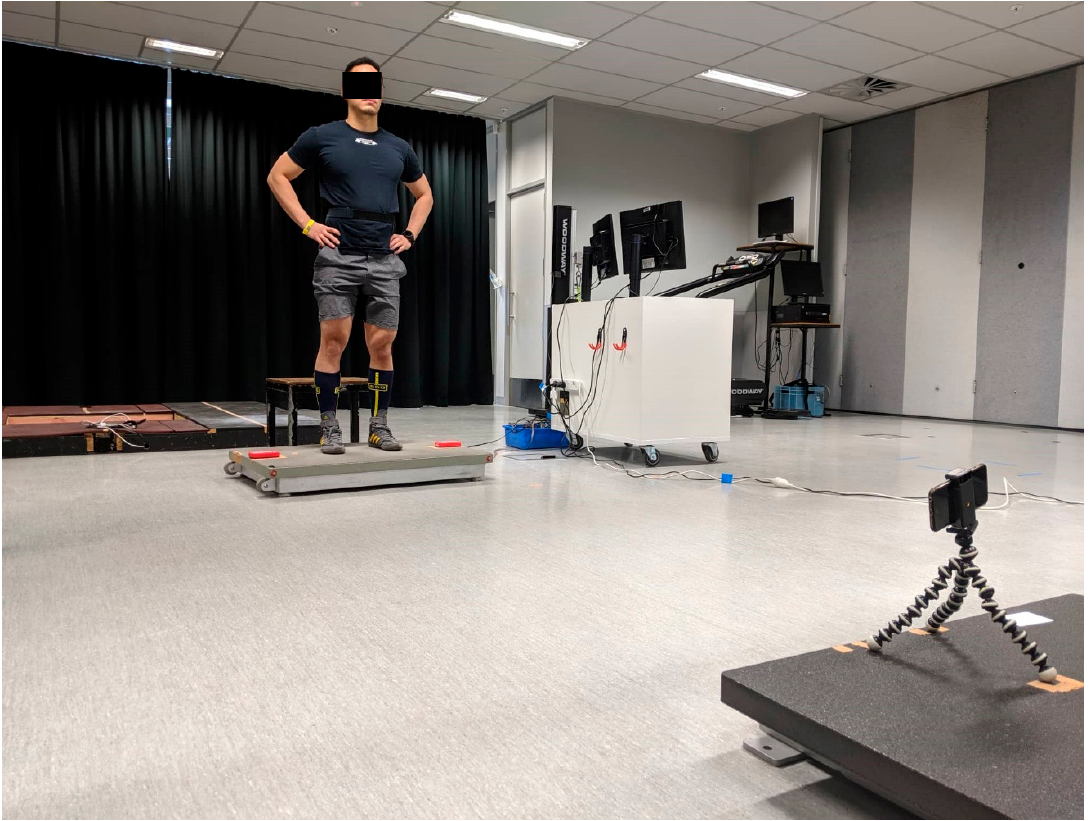
Figure 1. Testing equipment set-up.